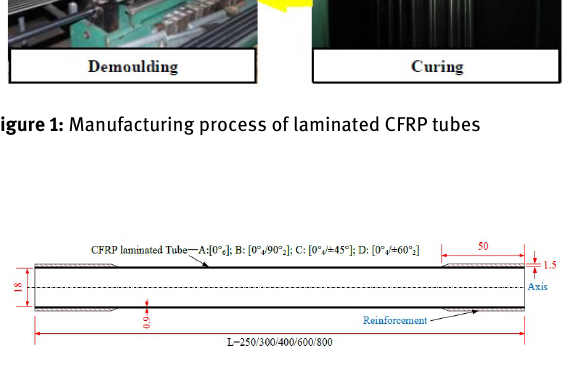
Figure 2: Schematic of the specimens (dimensions unit: